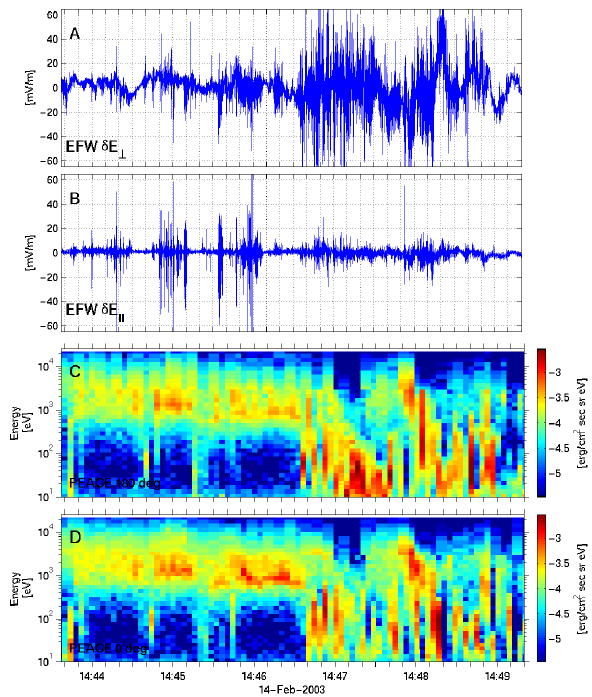
Fig. 4. A detail of the event in Fig. 1. Perpendicular (panel A ) and parallel (B) components of the electric field; upgoing (C) and downgoing (D) electron energy spectra. There is a sharp boundary (around 14:46:40 UT) with a dramatic change in both the electric field (A and B) and in the electron data (C and D). Waves with a large parallel component of the electric field are only observed when there are no cold electrons detected. There is an overall good correlation between wave emissions and electron